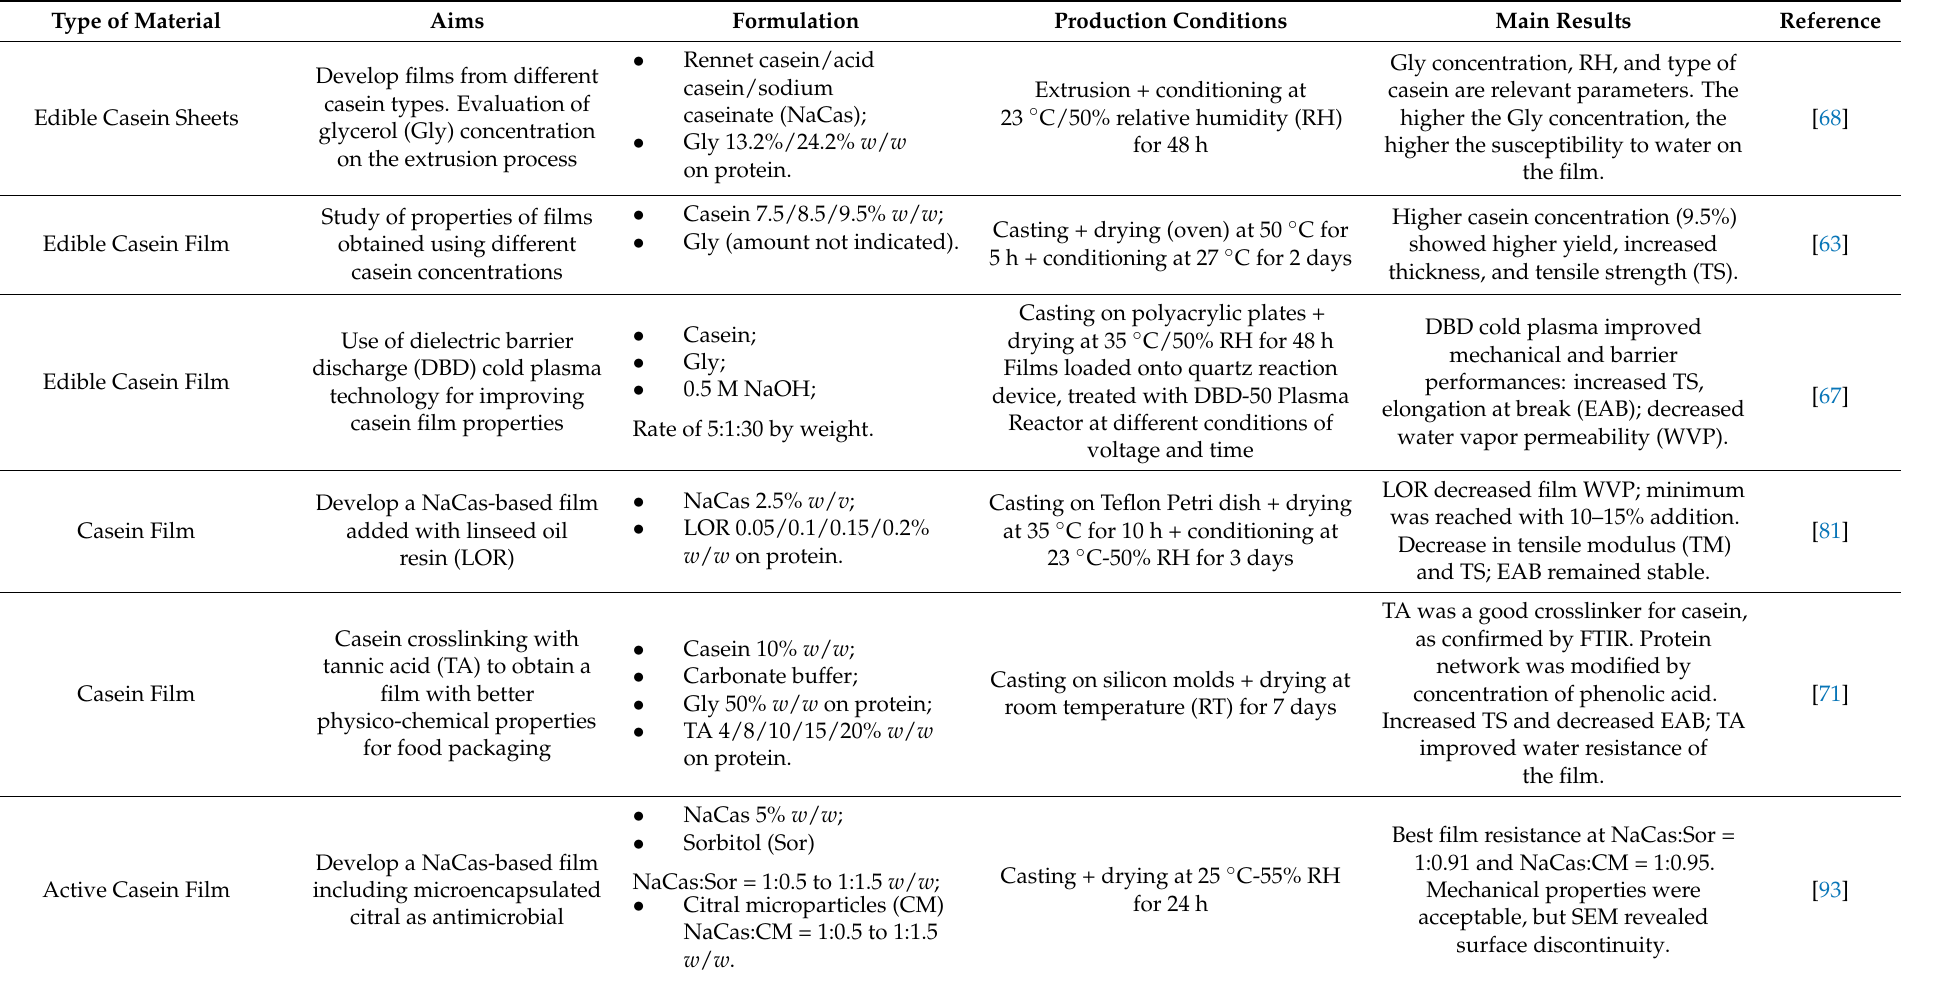
Table 2. Overview of the recent studies aimed at developing milk-protein-based